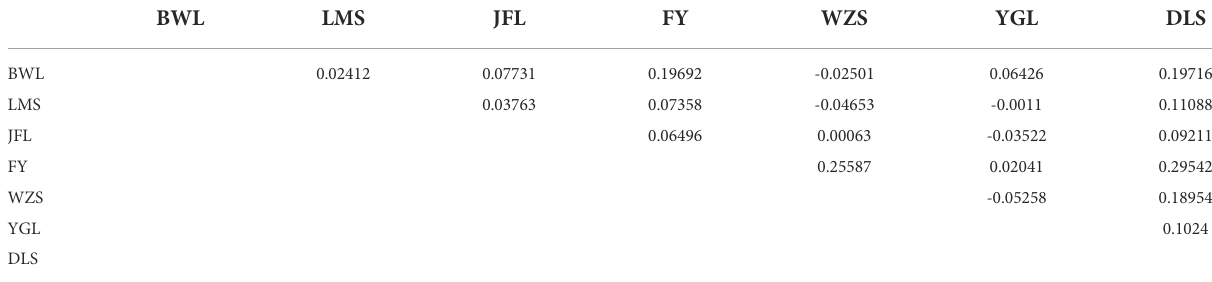
TABLE 4 Genetic differentiation coef fi cient(F st : above diagonal).